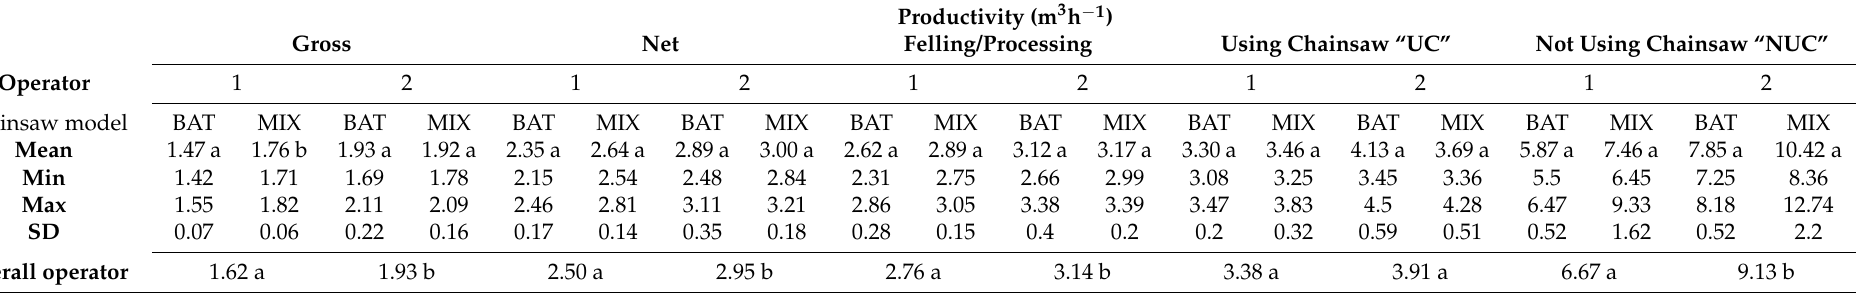
Table 5. Overall productivity dataset and statistics for each operator (1 and 2) and chainsaw models (BAT-battery MSA 300; MIX-petrol MS 261